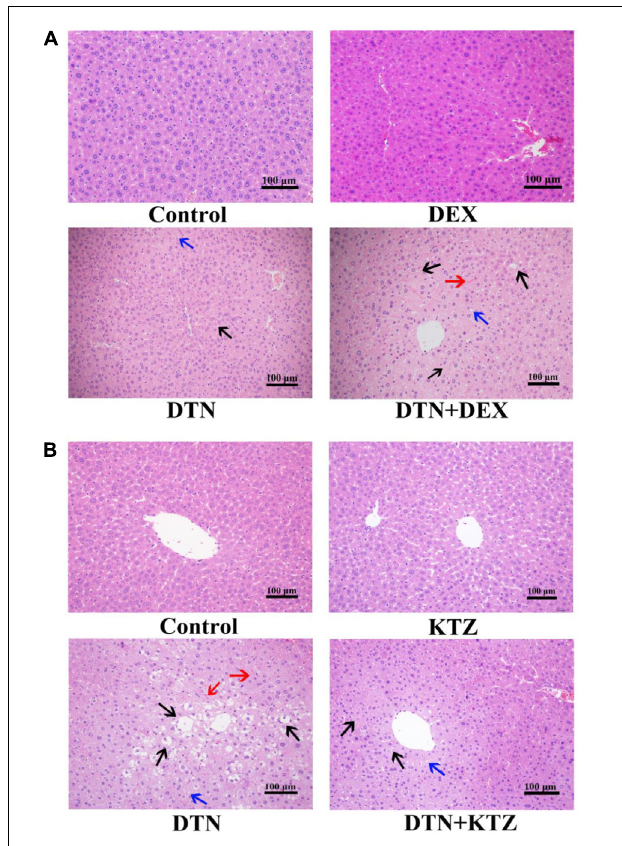
FIGURE 9 | Histopathological evaluation (H&E staining) of liver tissues obtained from mice. Typical images were chosen from each experimental group. (A) Livers from mice exposed to DTN (a single dose of 640 mg/kg) in combination with DEX (70 mg/kg) and vehicle. (B) Livers from mice exposed to DTN (320 mg/kg for 4 days and 640 mg/kg on the 5th day) in combination with KTZ (75 mg/kg, 1.5 h before the last administration) and vehicle. (Original magnification 100 × ; the scale bar is 100 µ m).